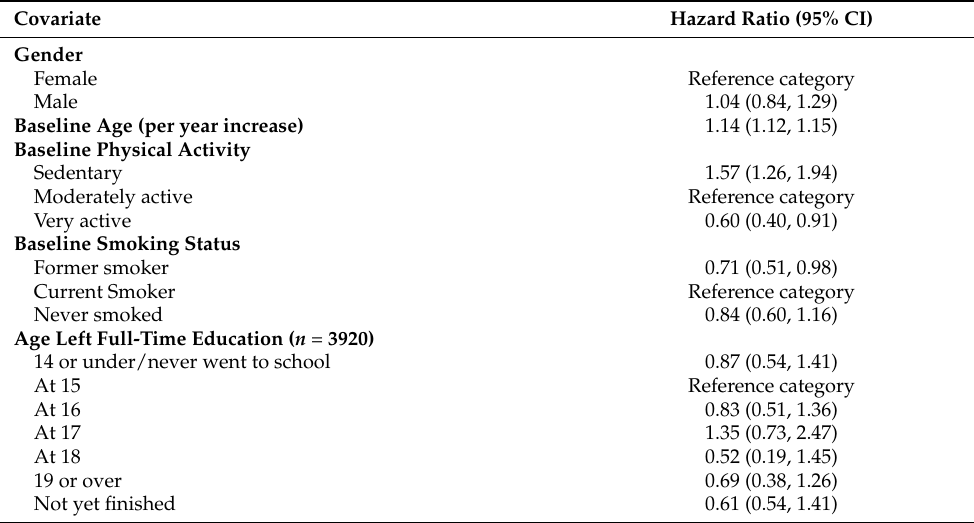
Table 3. Cox proportional hazards ratios (confidence intervals) for covariates included in dementia incidence analysis of ELSA respondents across England.